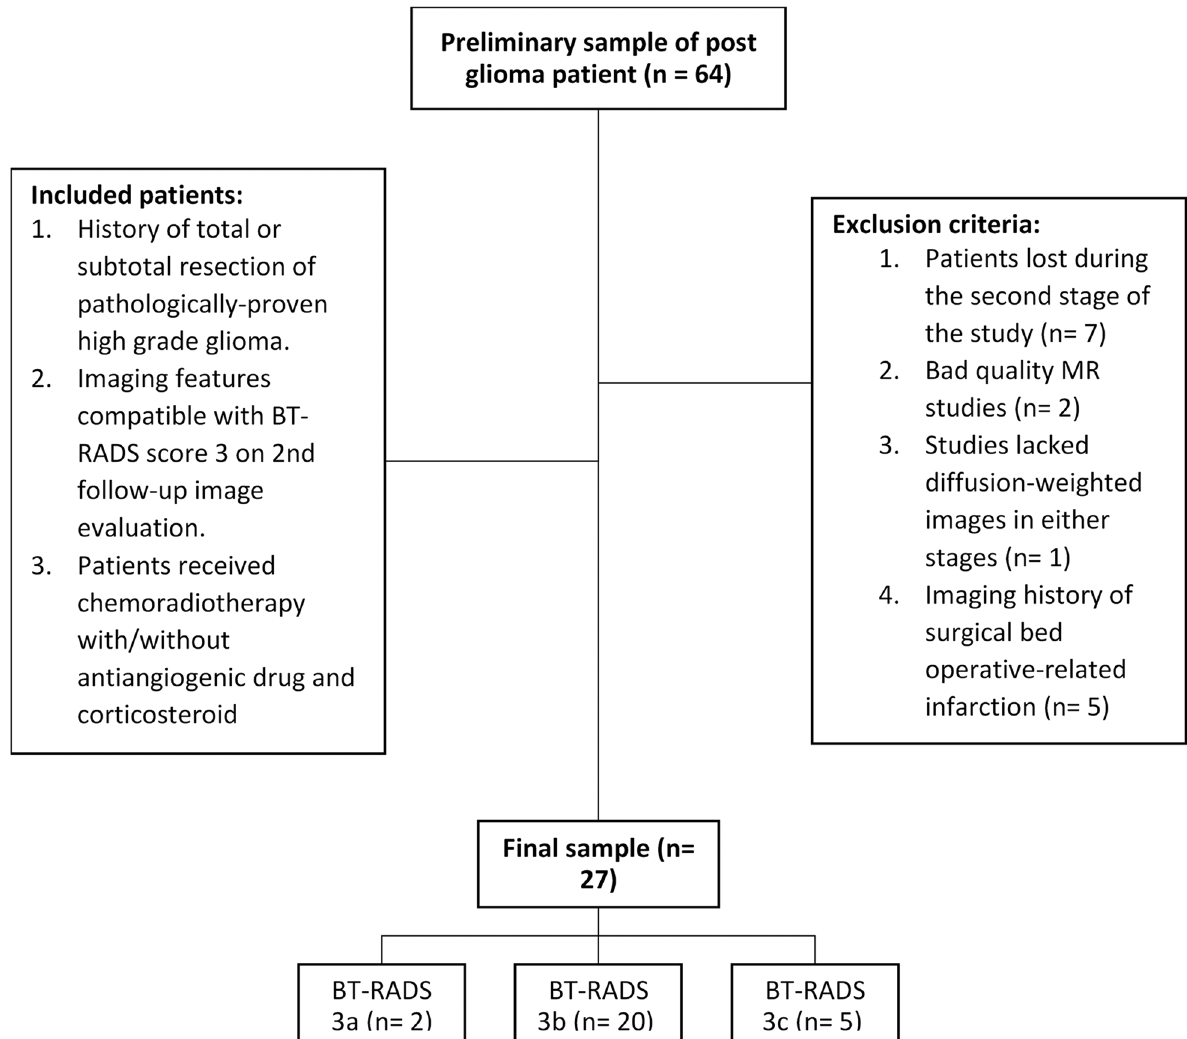
Fig. 1 Flowchart of the recruited patients. BT-RADS